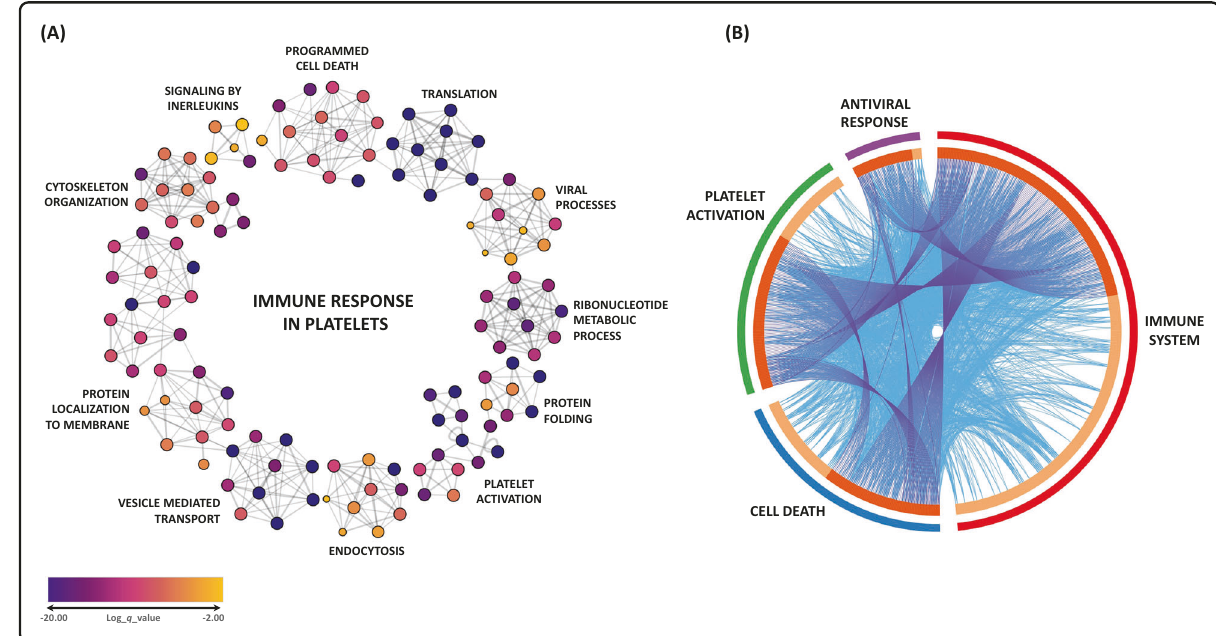
Fig. 2 Interactome analysis and enrichment annotation of all biological processes that involve differentially abundant proteins from both comparisons in the platelet proteome of COVID-19 patients. A Each node represents an enrichment term statistically ranked by color. B Circus plot shows the overlap in differentially abundant proteins. On the outer side of the plot, the arcs represent the main biological process of each protein list. In the inner part, proteins that appear in multiple biological processes are represented in dark orange, whereas proteins unique to a biological process are depicted in light orange. Blue and purple links inside the plot indicate the degree of functional overlap among the protein